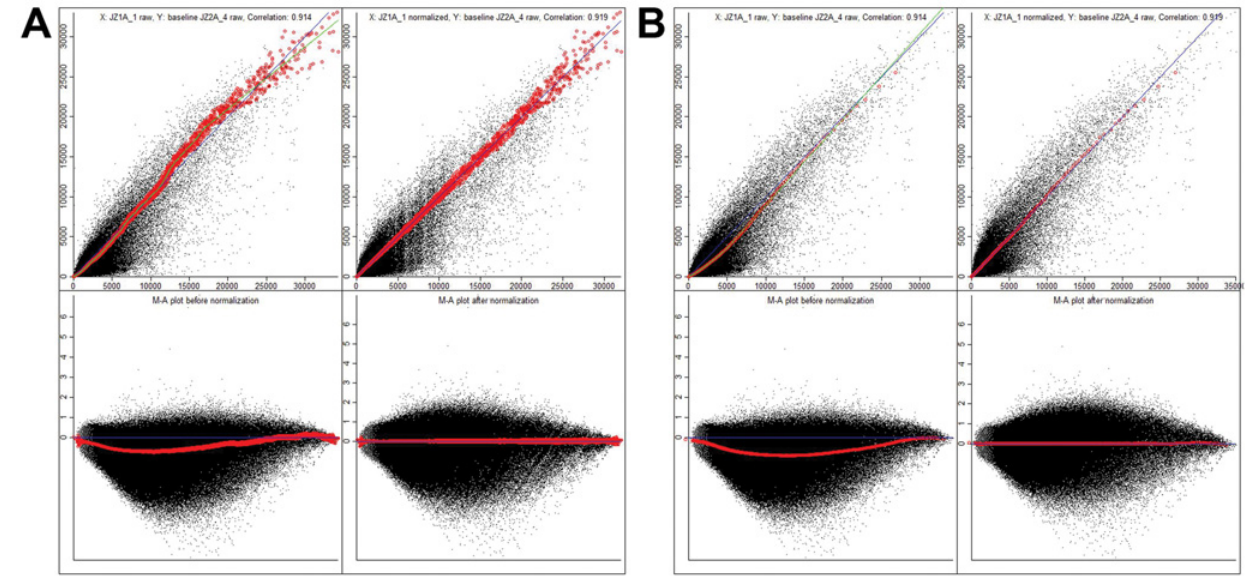
Fig 2. Normalization of gene expression arrays of PNET cells grown on PS or PAA. (A) By ranked invariant set normalization.. All probes were normalized using dChip software implementation of ranked invariant set normalization. The x and y-axis on each of the top panels represent the probes signal intensity values of a PS sample (x-axis) compared to a PAA sample (y-axis) before (left) and after (right) normalization. The bottom graphs are a transformation of the distribution into an MA plot. (Descriptions inside the figure: A: upper left panel — X: JZ1A_1 raw, Y: baseline JZ2A_4 raw, correlation: 0.914; lower left panel — M-A plot before normalization. A: upper right panel — X: JZ1A_1 normalized, Y: baseline JZ2A_4 raw, correlation: 0.919; lower right panel — M-A plot after normalization). (B) By quantile normalization. All probes were normalized using dChip software implementation of quantile normalization. The x and y-axis on each of the top panels represent the probes signal intensity values of a PS sample (x-axis) compared to a PAA sample (y- axis) before (left) and after (right) normalization. The bottom graphs are a transformation of the distribution into an MA plot. (Descriptions inside the figure: B: upper left panel — X: JZ1A_1 raw, Y: baseline JZ2A_4 raw, correlation: 0.914; lower left panel — M-A plot before normalization. B: upper right panel — X: JZ1A_1 normalized, Y: baseline JZ2A_4 raw, correlation: 0.919; lower right panel — M-A plot after normalization.)